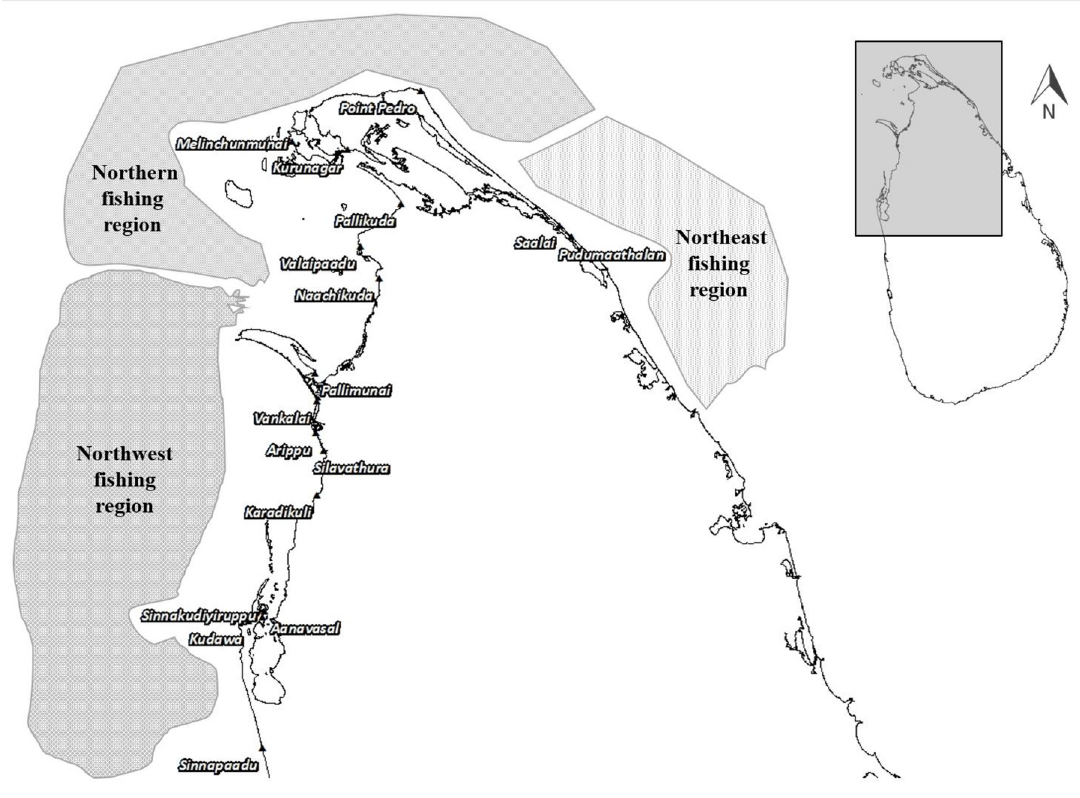
Fig. 1. Map showing the sea cucumber landing sites integrated into this study in the north, north-east and north-west regions of Sri